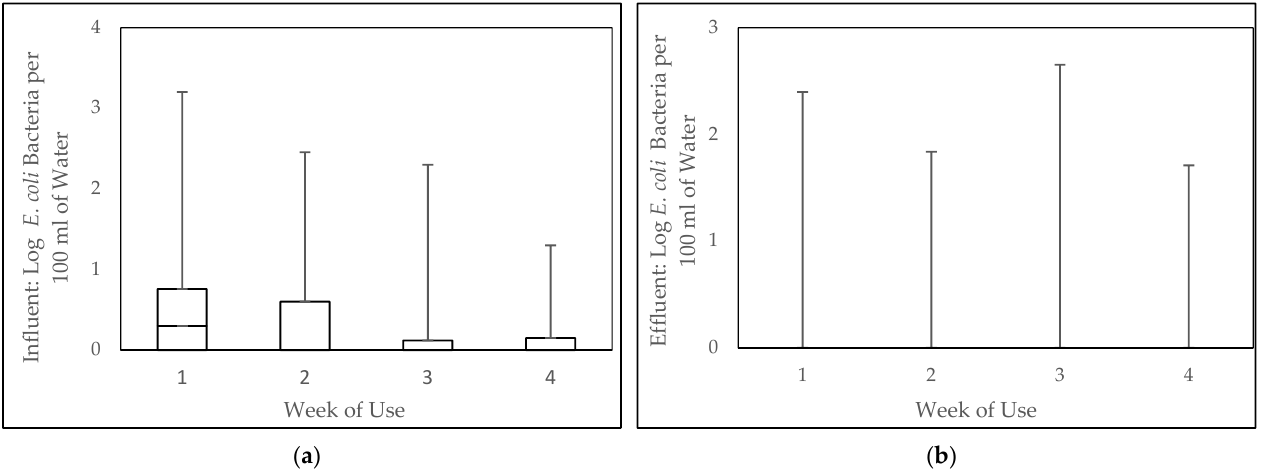
Figure 13. Box and whisker plot of total coliform bacteria concentration in water taken from the home and intervention spigot over four weeks. ( a ) displays the log of total coliform bacteria concentration in water taken from untreated source water used by the household to fill the intervention. ( b ) displays the log of total coliform bacteria concentration in treated water from the spigot. In each figure, the top and bottom boxes in each column represent the second and third quartile of the data, respectively. The line that separates them indicates the median, and the lower and upper whiskers indicate the first and fourth quartile of the data.